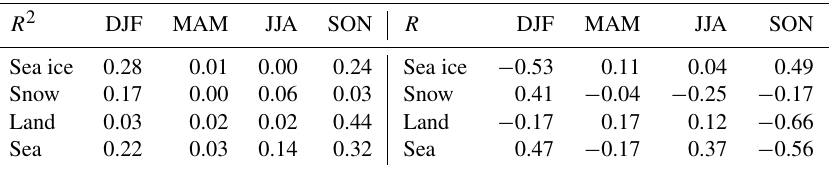
Table 1. The correlation of the time that air masses spent over different surfaces, and the GEM concentration shown for the different seasons (DJF – December, January and February; MAM – March, April and May; JJA – June, July and August; SON – September, October and November.). Values for both R and R 2 are